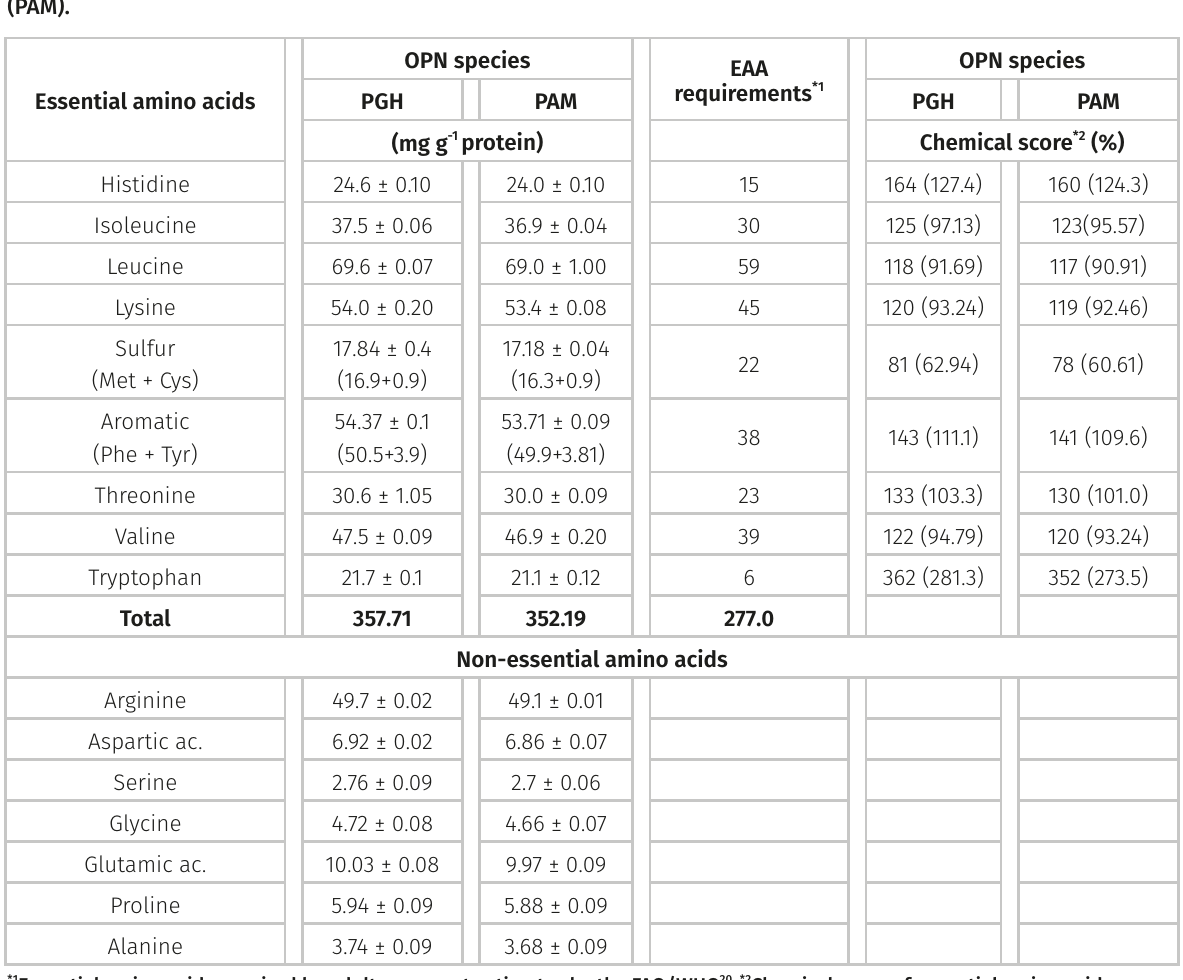
Table I. Mean values and standard deviation of the amino acid levels (dry basis) and chemical score of the essential amino acids of the proteins in leaves of Pereskia grandifolia Haworth (PGH) and Pereskia aculeata Miller (PAM).